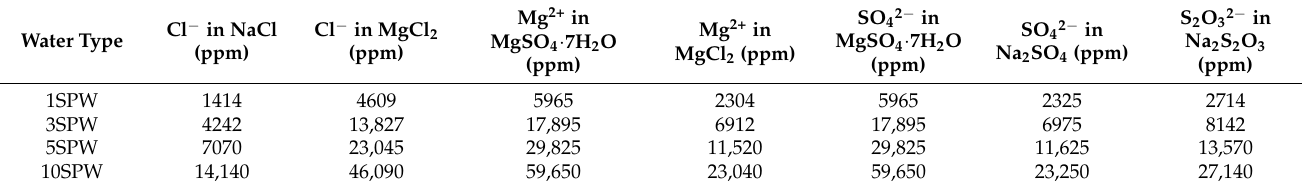
Table 1. Composition of single salt ion concentrations (adapted from